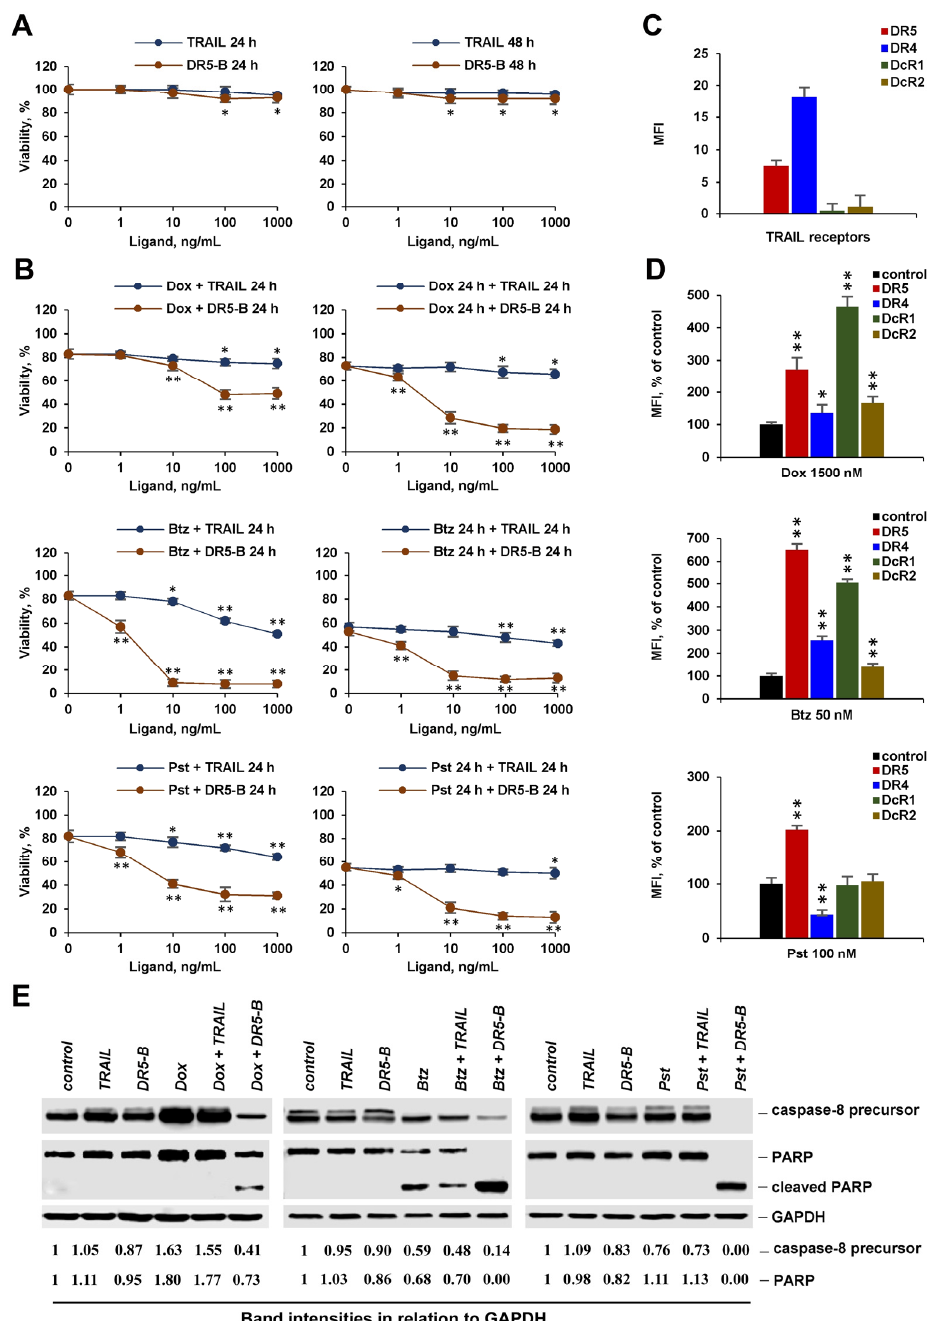
Figure 4. Chemotherapeutic agents at low concentration sensitize A549 cells to DR5-B but not to TRAIL. ( A ) Cells were treated with TRAIL or DR5-B for 24 h and 48 h. ( B ) Cells were treated with TRAIL or DR5-B in combination with 1500 nM doxorubicin (Dox), 50 nM bortezomib (Btz) and 100 nM panobinostat (Pst) for 24 h. In a sequential treatment mode, cells were pretreated with the chemotherapeutic agents for 24 h, followed by treatment with the ligands for another 24 h. Cell viability was quantified by Wst-1 assay. Surface expression of death and decoy receptors before ( C ) and after ( D ) treatment with the chemotherapeutic agents at indicated concentrations determined by flow cytometry. Mean ± Standard Deviation ( n = 3). The asterisks indicate significance (* p < 0.05) and (** p < 0.001) relative to cells treated with chemotherapy without ligands. ( E ) Cells were pre-incubated with the chemotherapeutic agents for 16 h, followed by 1000 ng / mL ligands for another 6 h for Dox and Pst and 3 h for Btz. Cleavage of caspase-8 and PARP (Poly(ADP-ribose) Polymerase-1) proteins was